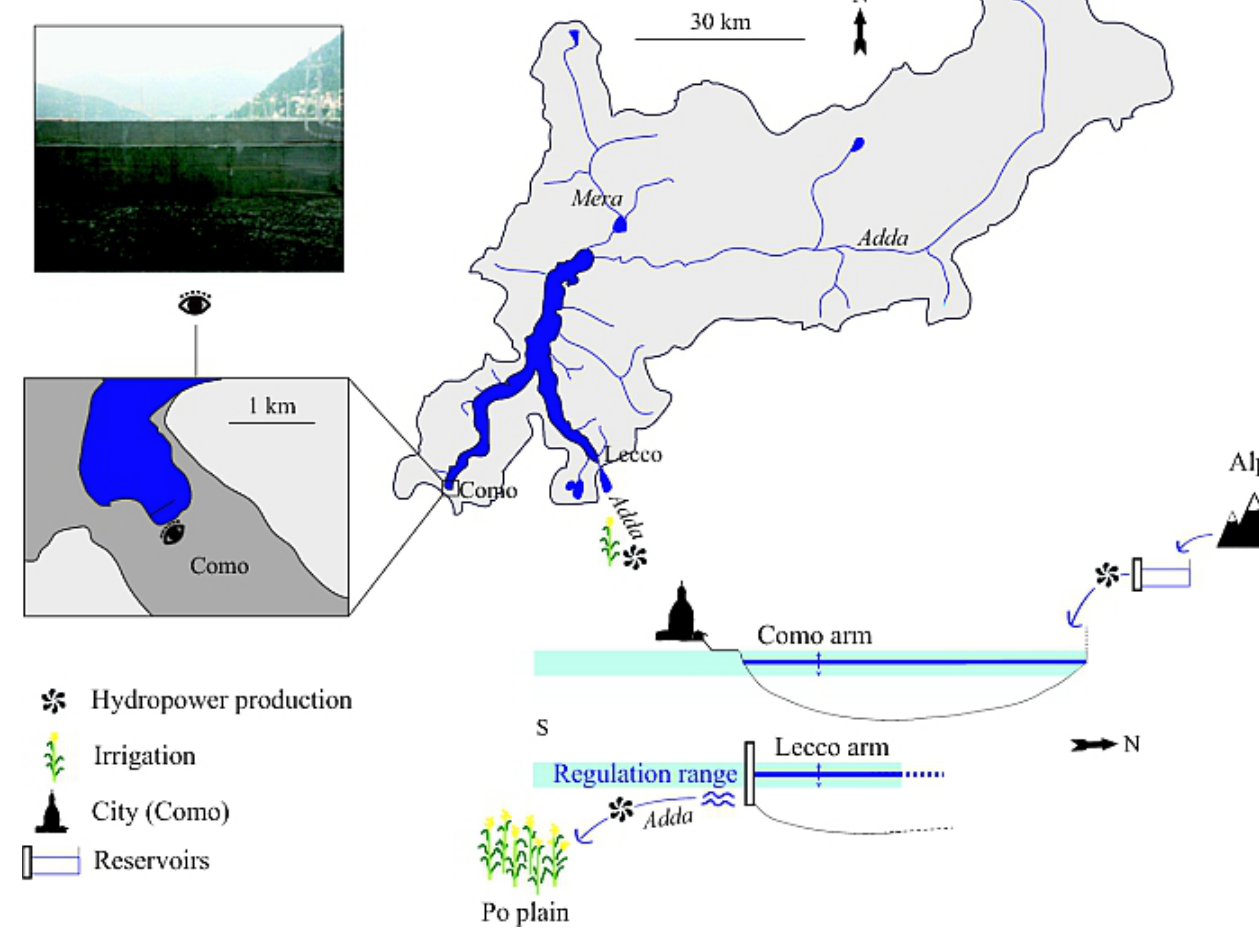
Fig. 1. Upper left: photograph showing the wall as seen through a window in a wooden fence along the footpath (taken by first author in October 2009). Upper right: map of Lake Como and its catchment. Bottom left: close-up of the city of Como. Bottom right: schematic drawing of the catchment